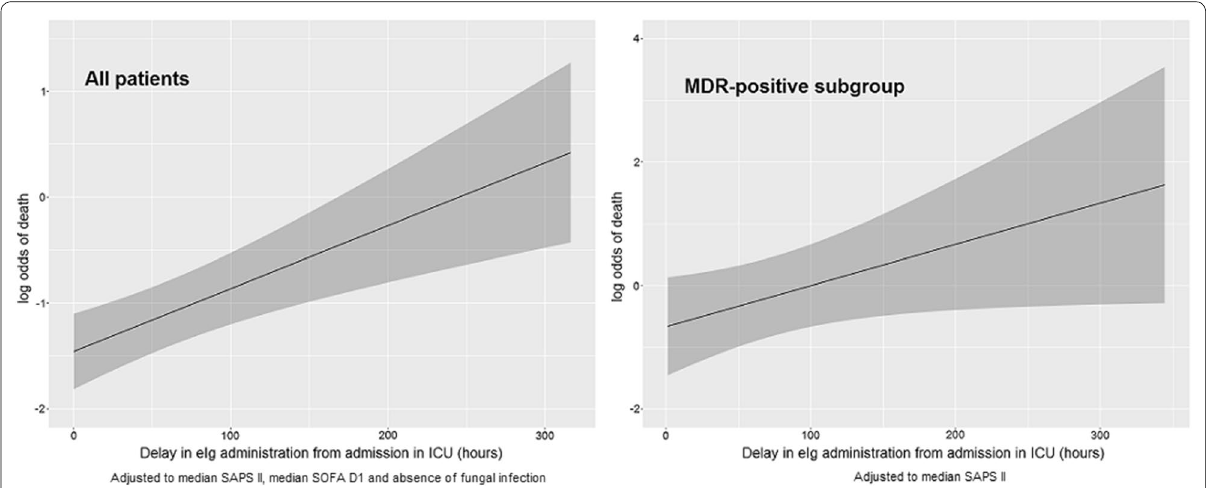
Fig. 2 Logit function from the multivariable logistic regression model in the group of all patients (right) showing the effect of delay in administration of IgM-enriched immunoglobulins on the probability of in-ICU death (solid line) with 95% confidence interval (gray area) adjusted to median value of SAPS II, SOFA D1 and without fungal infection. Comparison with logit functions from the multivariable logistic regression model for MDR-positive patients adjusted for median value of SAPS II (left). ivIgGAM, intravenous IgM- and IgA-enriched immunoglobulins; ICU, intensive care unit; MDR, multidrug resistant; SAPS II, Simplified Acute Physiology Score; SOFA D1, sequential organ failure assessment calculated the first day of administration of